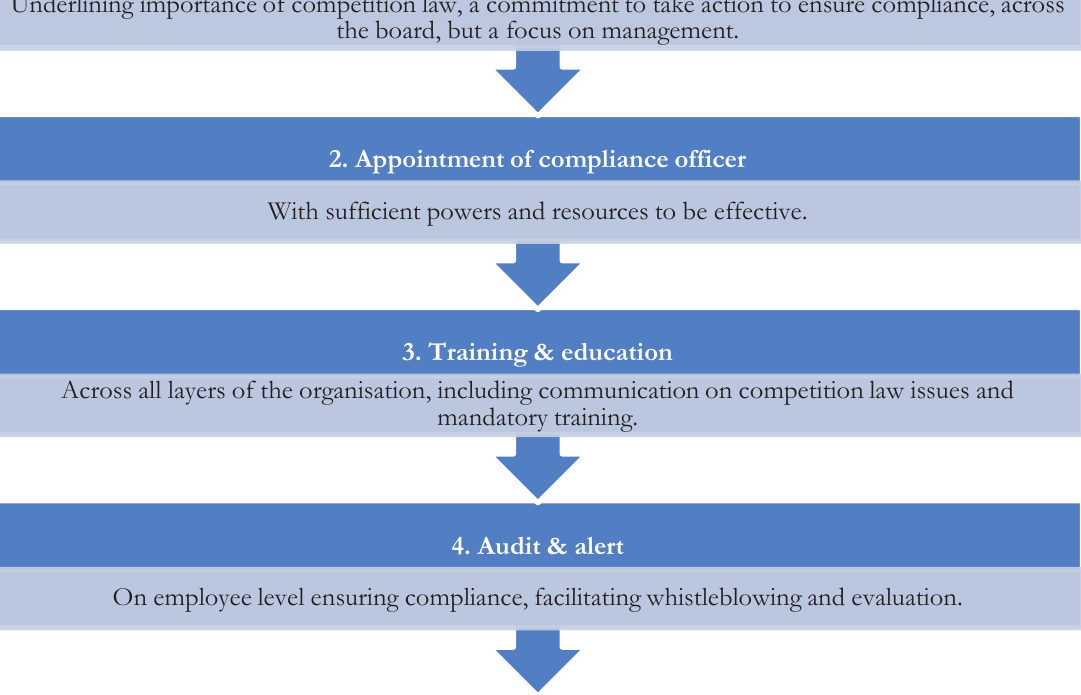
Figure 2 Five-step approach to